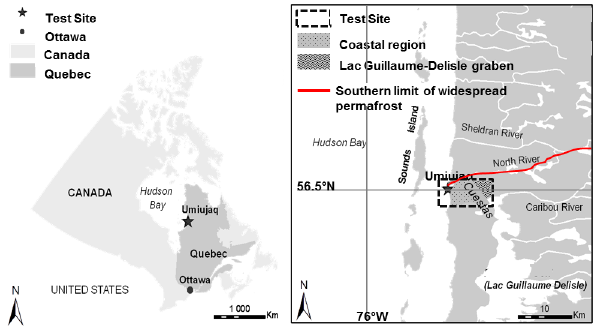
Figure 2. Location of the study area in the vicinity of Umiujaq, northern Quebec, Canada (left), and the distribution of the two main types of landscape (right): the coastal region to the west of the cues- tas and the Lac Guillaume-Delisle graben to the east of the cuestas. The approximate boundary between widespread discontinuous per- mafrost to the north and sporadic permafrost to the south (based on Allard and Séguin, 1987) is shown in